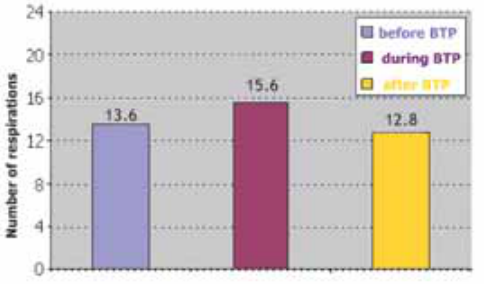
FIGURE 4. The mean of pCO